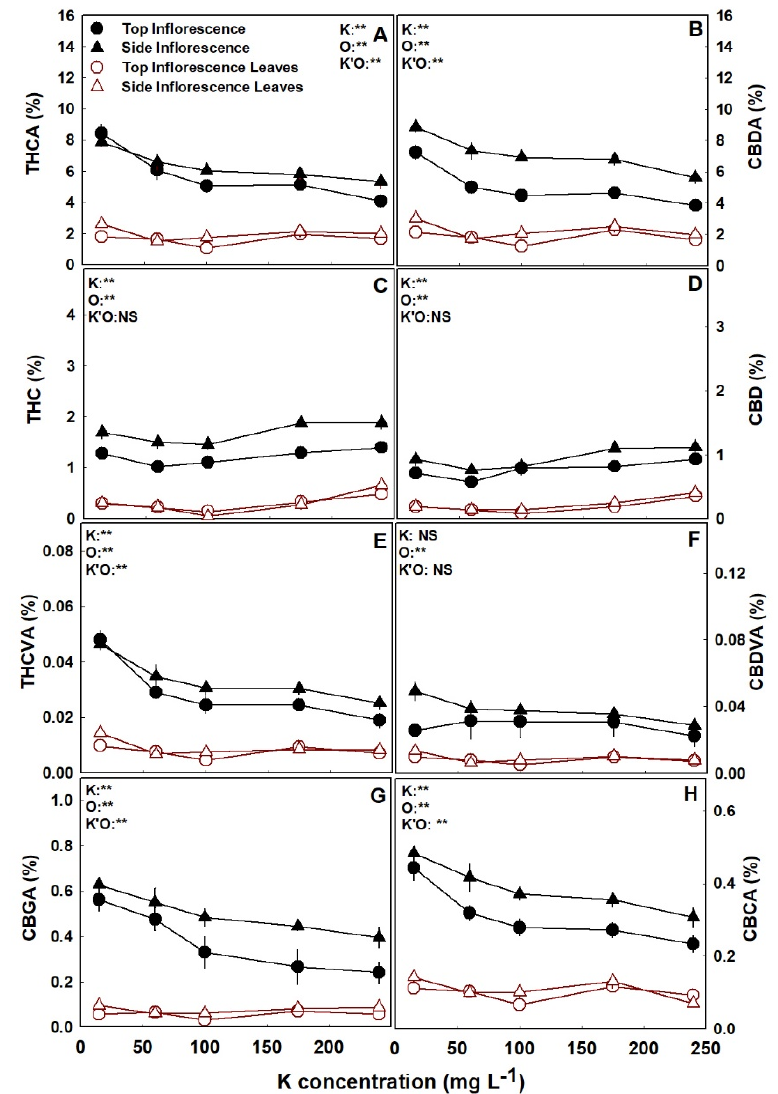
Figure 3. Effect of K supply on cannabinoid content in the medical cannabis cultivar RM, at the top (primary) and side (secondary) inflorescences and the inflorescence leaves. THCA ( A ), CBDA ( B ), THC ( C ), CBD ( D ), THCVA ( E ), CBDVA ( F ) CBGA ( G ), CBCA ( H ). Presented data are averages ± SE ( n = 5). Where not seen, the error bars are smaller than the symbol size. Results of two-way ANOVA indicated as ** p < 0.05, F -test; NS, not significant p > 0.05, F -test. In the ANOVA results, K’O represents the interaction between K and the plant organ. Results in units of mg g − 1 are presented in Figure S5 Supplemental.